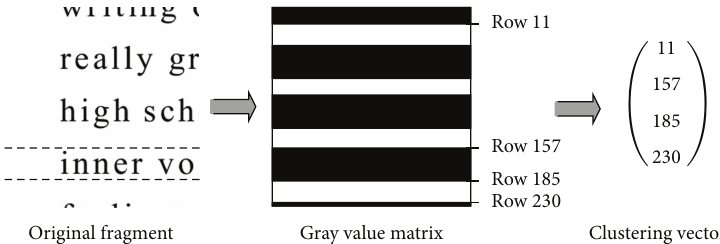
Figure 9: Example of feature extraction.